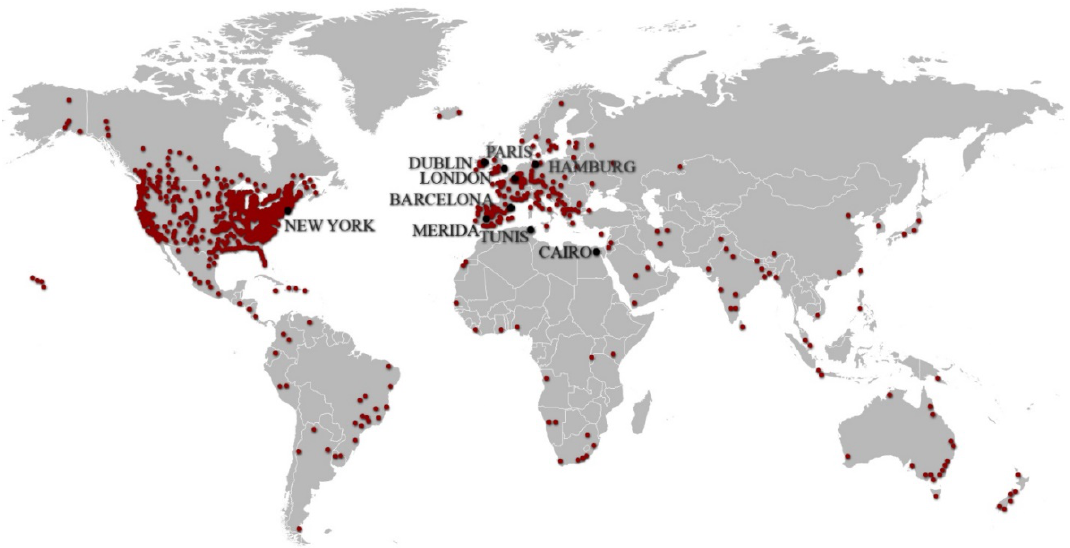
Figure 1 Urban movements and case study areas in the world (Red marks indicate the worldwide urban movements and black marks indicate the selected cities. The illustration is made by authors based on information taken from the following reference: Anon,